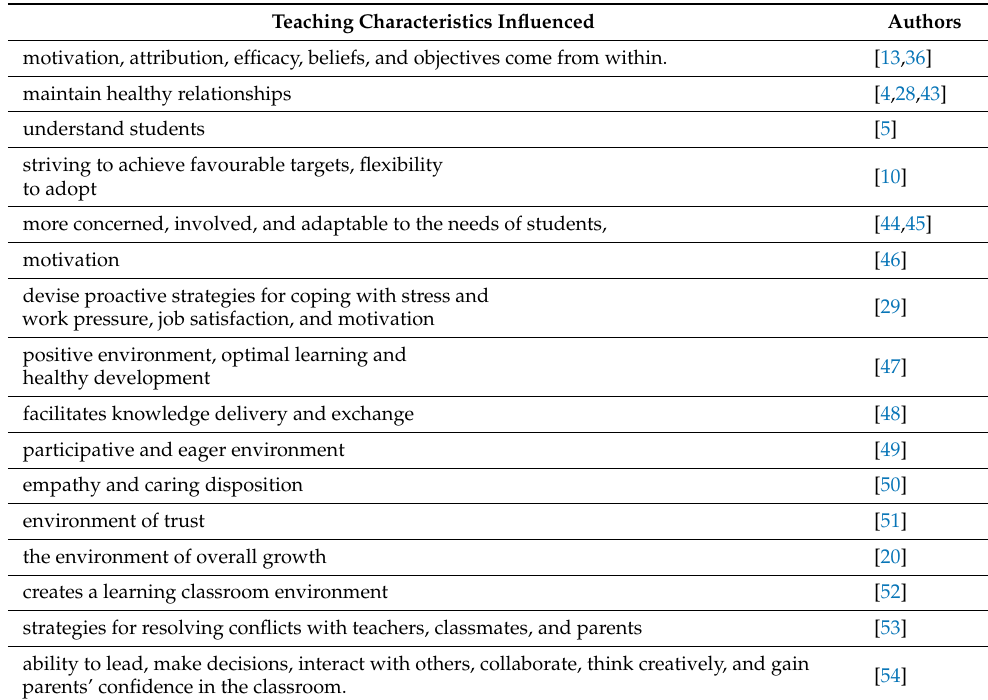
Table 1. Teaching Characteristics Influenced by